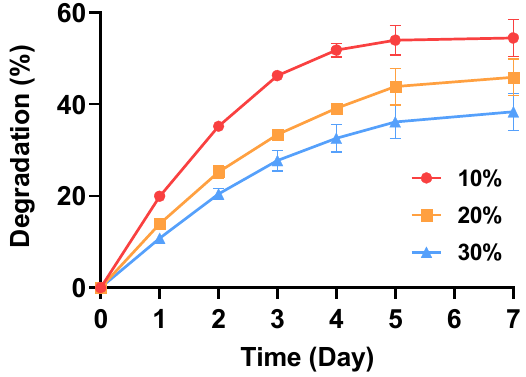
Figure 6. The degradation profiles of furfuryl-gelatin hydrogels.